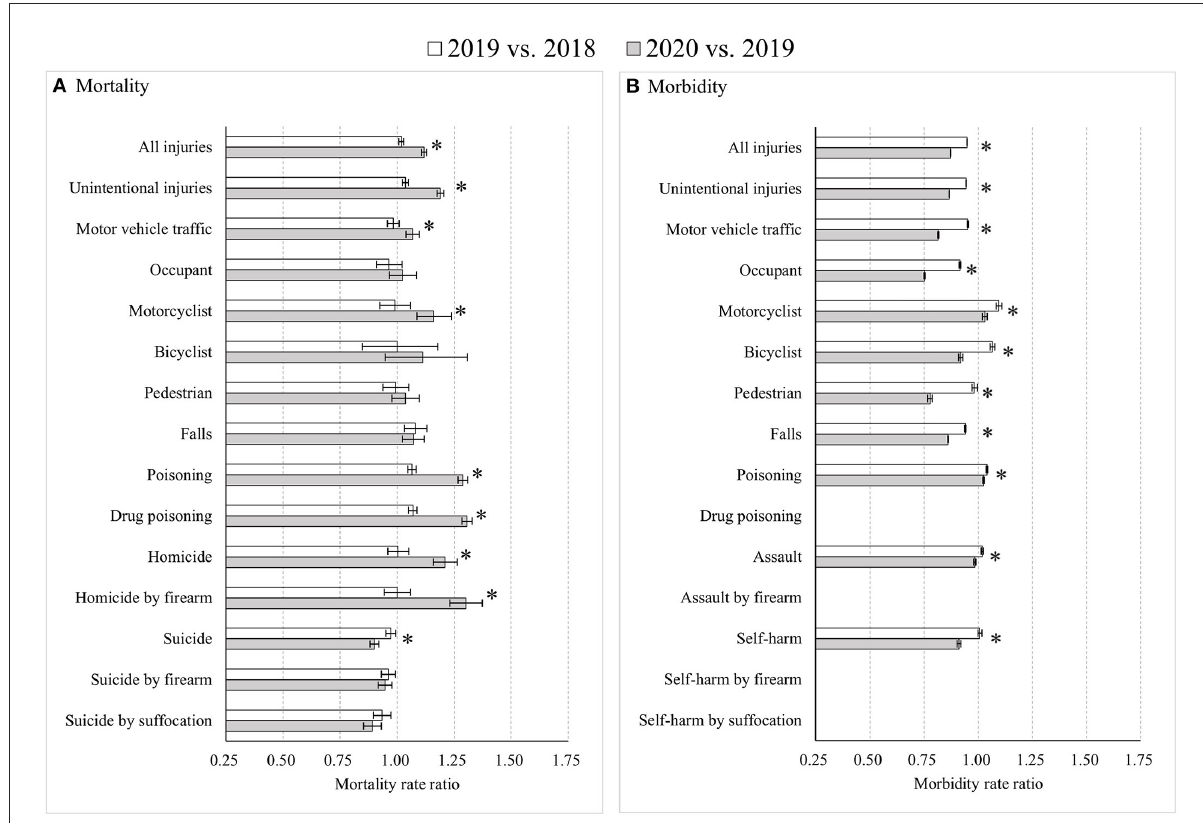
FIGURE4 Age-standardized injury mortality/morbidity rate ratios among Americans aged 45–64 years old, 2019 vs. 2018 and 2020 vs. 2019. (A) Mortality; (B) Morbidity. Results were omitted for categories having unstable injury morbidity rates (due to the computation based on cases < 20, the national estimates < 1,200, the coefficient of variation > 30%, or the tool not involving details regarding mechanism of relevant injury). “*” indicates that the differences of MtRRs or MbRRs between 2020 vs. 2019 and 2019 vs. 2018 were statistically